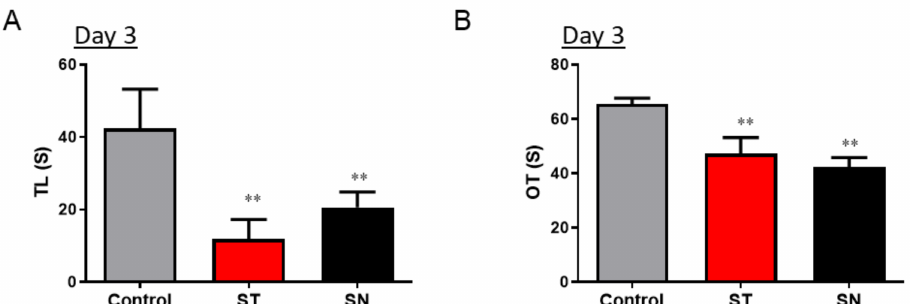
Figure 2. Treatment with streptomycin causes anxiety in C57BL/6 mice. Streptomycin (20 mg/day) was administered to mice from both the experimental groups on day 1. The LDB ( A ) and EPM ( B ) tests were conducted on day 3 after streptomycin treatment to study anxiety-like behaviors, ** p < 0.01 for control vs. ST and SN mice. (LDB: light-dark box; EPM: elevated plus maze; TL: time spent in light chamber (in seconds); OT: time spent in open arms (in seconds); ST: streptomycin alone-treated group; SN: streptomycin- and EcN-treated